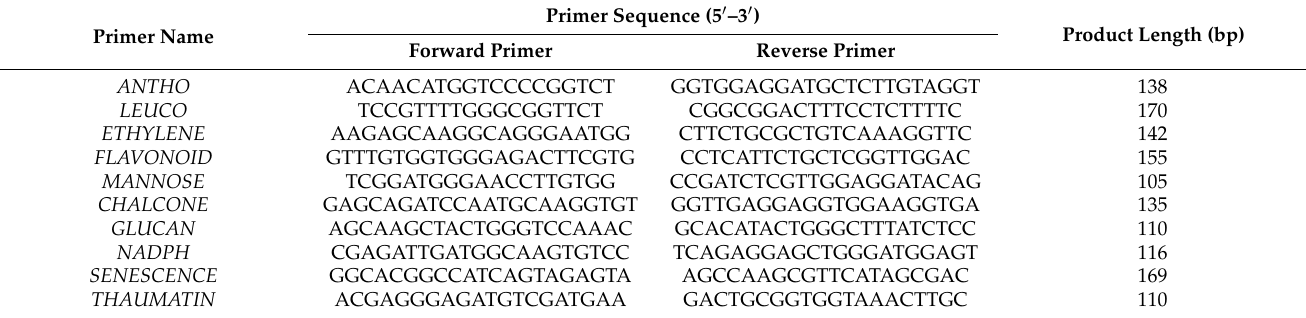
Table 5. List of primer sequences of the selected DEGs at different stages of G. boninense infection. Primer